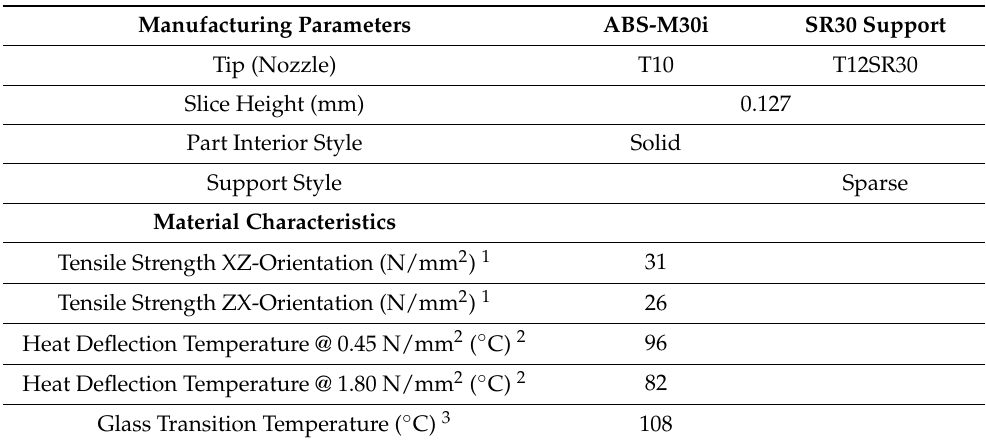
Table 1. Manufacturing parameters and relevant material characteristics of ABS-M30i and SR30 Support of the FDM printer Stratasys Fortus 400mc Large